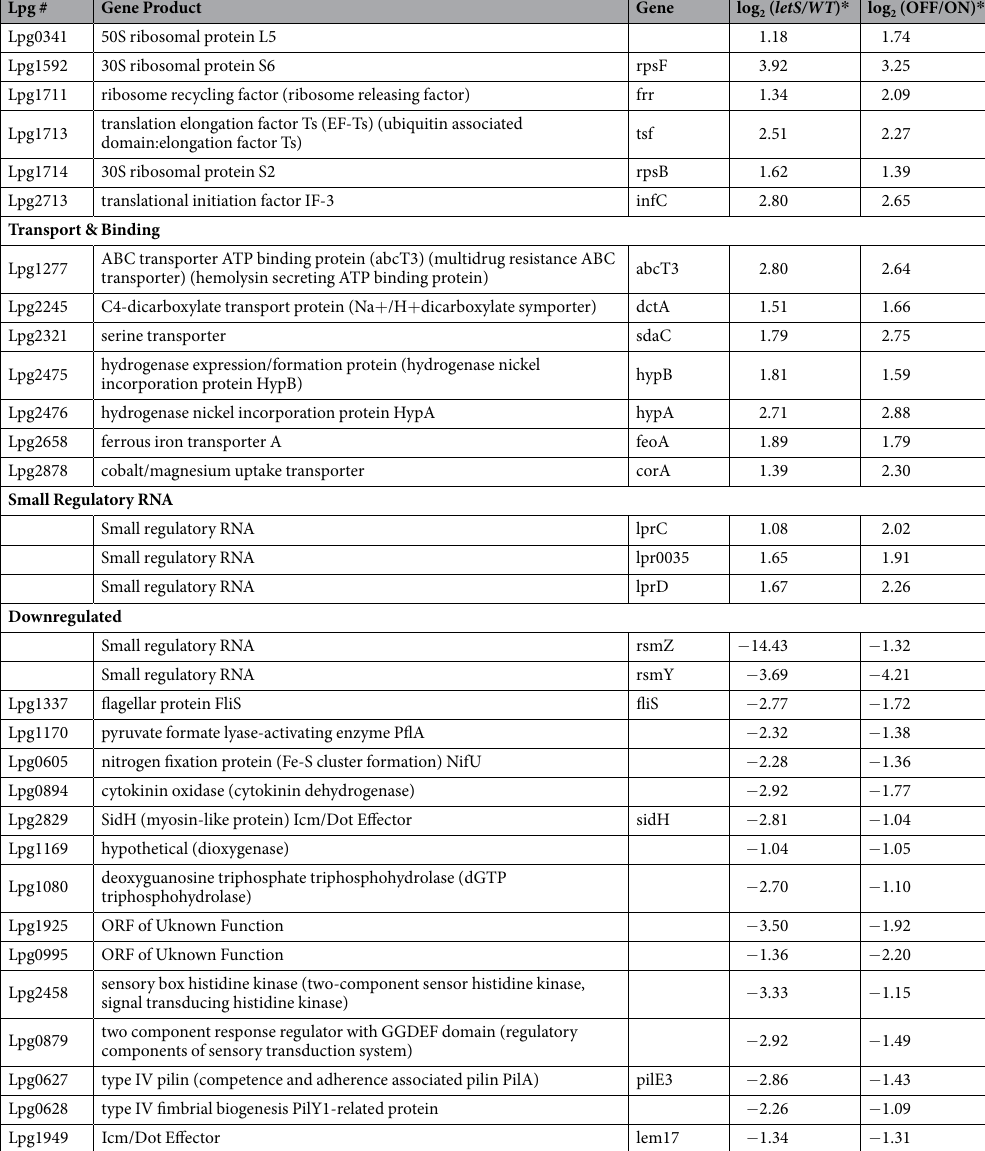
Table 1. Select genes differentially regulated in ∆ letS vs . WT and OFF vs . ON. * Only significant values (P < 0.05) are